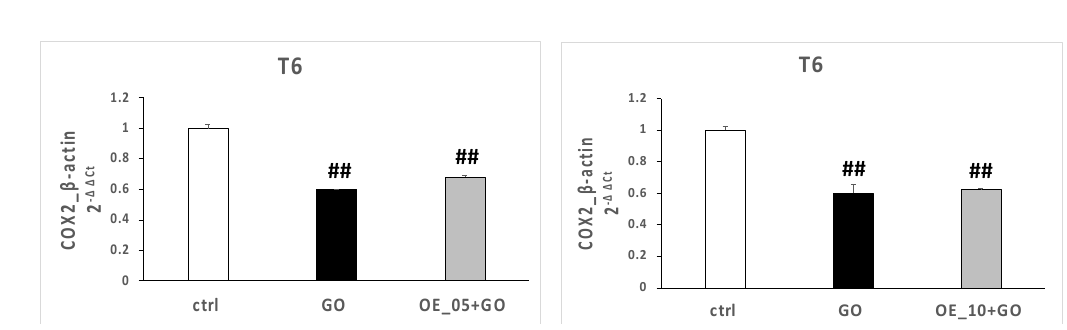
Figure 5. ( a ) Immunofluorescence staining of DAPI (blue) and NF- κ B (green) in CaCo-2 cells treated with 20 µ g/mL of OE_05 or OE_10 for 24 h and exposed to GO 0.5 U/mL for 1 h. Timepoints at 0 and 1 h post-exposure (T0, T1). Original magnification at 40x; scale bar = 40 µ m. The immunofluorescent signal was semiquantified using ImageJ software (National Institutes of Health, Bethesda, MD) and the quantification graphs are displayed in the bottom panel. Transcript levels of IL-6 ( b ) and COX2 ( c ) measured using qRT-PCR 6 h post-GO-exposure in CaCo-2 cells pre-treated with EVOO extracts for 24 h. Data are the results of the averages of at least three different experiments, ## p < 0.01, ### p < 0.001 GO ± OE_05 or OE_10 vs. ctrl and ¥ p < 0.05, ¥¥ p < 0.01, ¥¥¥ p < 0.001 GO + OE_05 or OE_10 vs. GO as assessed by one-way